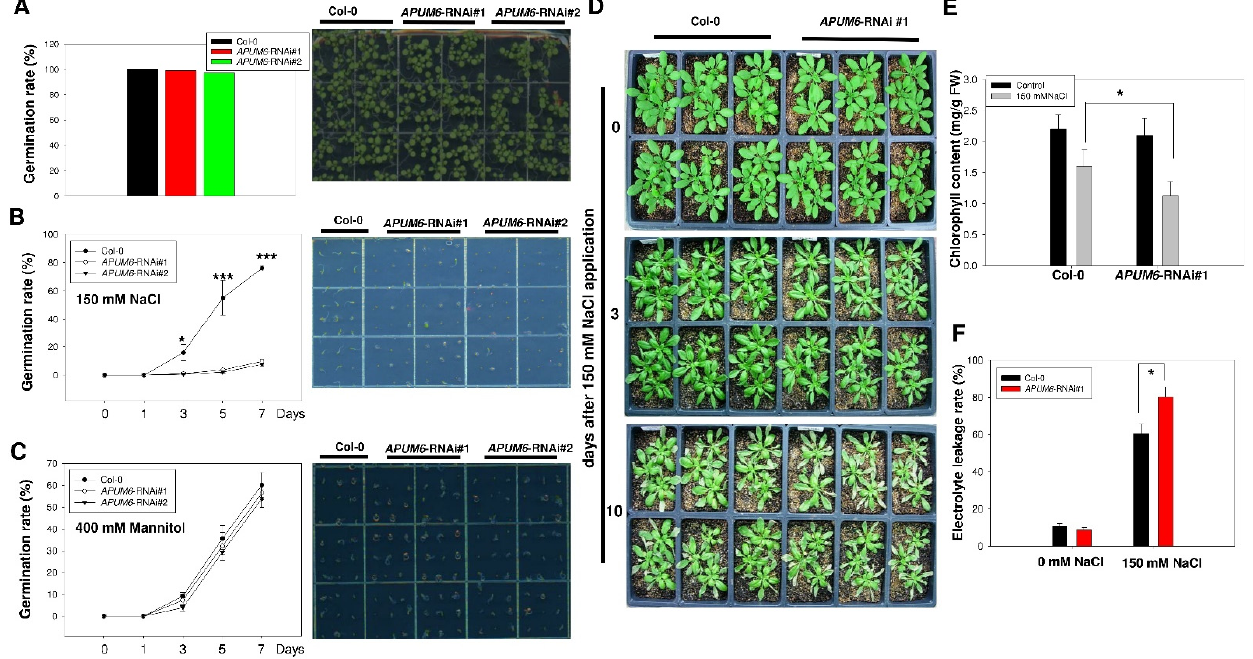
Figure 4. Effect of salt stress on seed germination in APUM6 -RNAi transgenic plants. ( A ) WT and APUM6 -RNAi transgenic seedlings 12 days after seeds were sown on 1/2 MS medium. Each data point is the mean of 3 replicates of 100 seeds. ( B , C ) WT and transgenic seedlings 10 days after seeds were sown on 1/2 MS or 1/2 MS supplemented with 150 mM NaCl and 400 mM mannitol. Bars indicate the standard errors of the mean data ( n =3), and different letters indicate significant differences (* p < 0.05, *** p < 0.001). ( D ) Performance of the Col-0 and APUM6 -RNAi#1 transgenic line after salt treatment for 10 days. Pictures were taken 0, 3, and 10 days after salt treatment. ( E ) Physiological changes associated with the salt stress response in WT and APUM6 - RNAi transgenic plants. Chlorophyll content was determined Data values represent the means ± SD from three independent experiments. Asterisks indicate statistical significance of the differences between transgenic lines and WT plants (* p < 0.05). ( F ) Relative electrolyte leakage in Col-0 and APUM6 -RNAi#1 transgenic plants after 150 mM salt treatments for 6 h. Data values represent the means ± SD from three independent experiments. Asterisks indicate statistical significance of the differences between transgenic lines and control plants (* p <